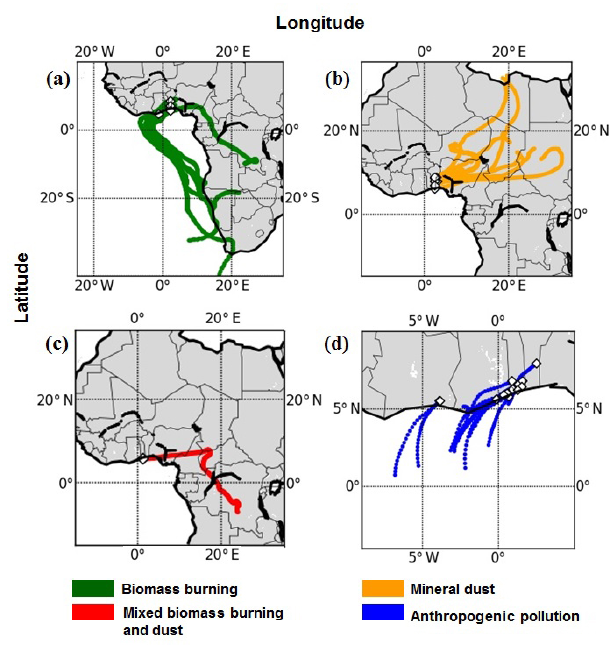
Figure 3. Backward trajectories for the analysed aerosol layers. Tra- jectories date back 10d for panel (a) , 5d for panels (b) and (c) , and 1d for panel (d)